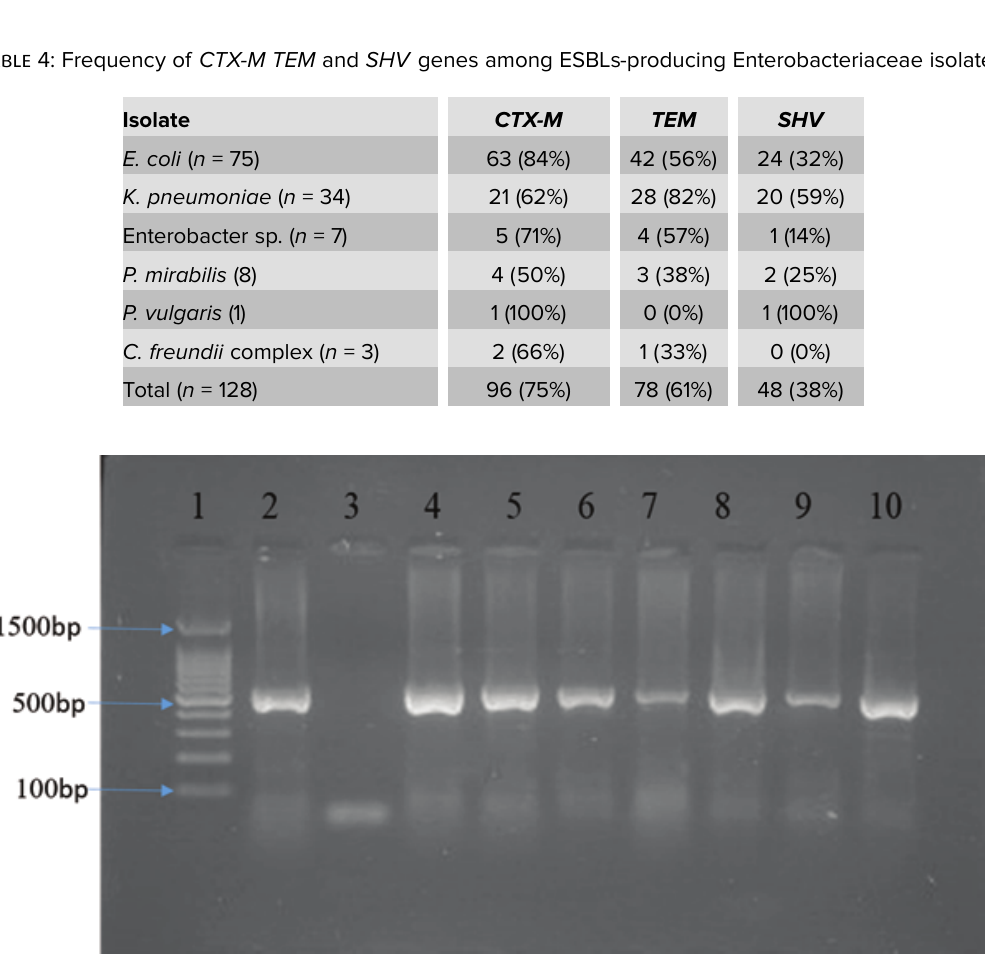
Figure 1: PCR amplification of CTX-M genes. Lane 1 DNA marker (100–1500 bp), lane 2 positive control, lane 3 negative control, lanes 4–10 were positive for CTX-M genes (550